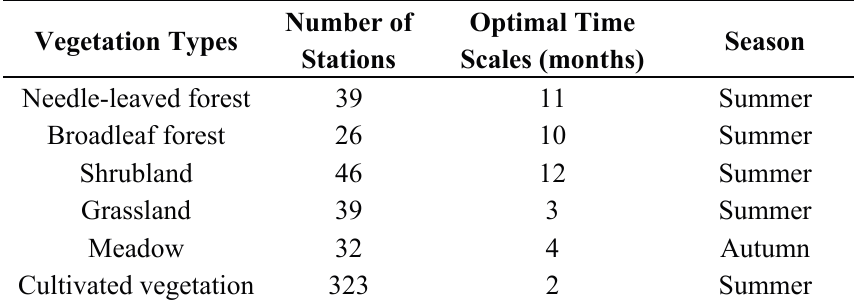
Table 2. The optimal time scales of SPEIs for different vegetation types.